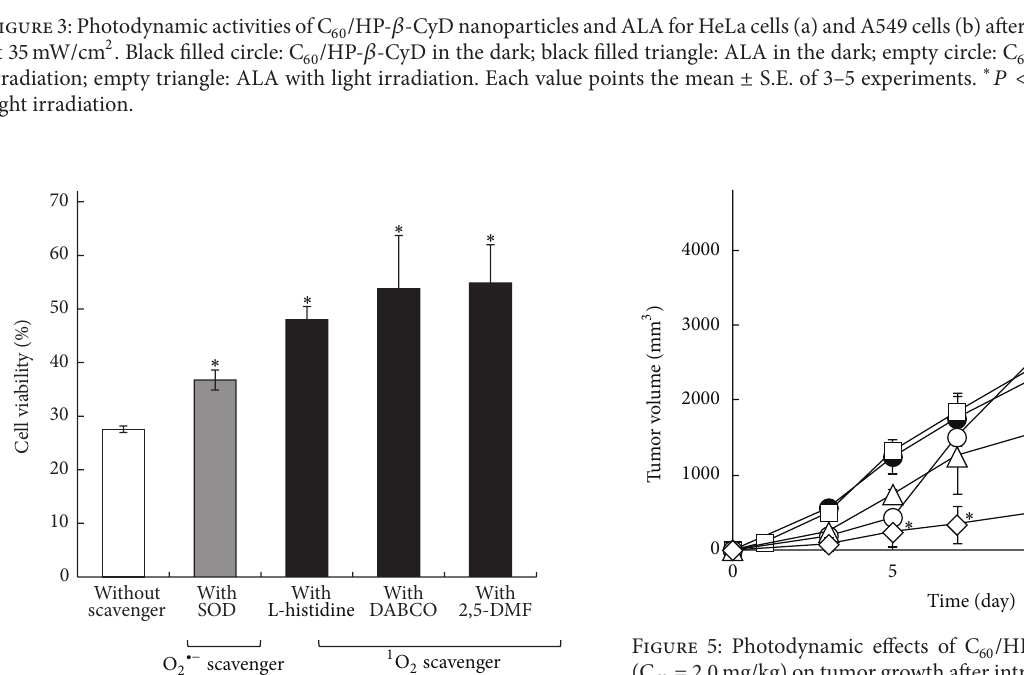
Figure 5: Photodynamic effects of C 60 /HP- 𝛽 -CyD nanoparticles (C 60 = 2.0 mg/kg) on tumor growth after intratumor injection to the tumor-bearing mice plus light irradiation. Black filled circle: saline; empty square: C 60 /HP- 𝛽 -CyD plus light irradiation (30J/cm 2 ); emptycircle:C 60 /HP- 𝛽 -CyDpluslightirradiation(60 J/cm 2 );empty lozenge: C 60 /HP- 𝛽 -CyD plus light irradiation (75J/cm 2 ); empty tri- angle: saline plus light irradiation (75 J/cm 2 ). Each point represents the mean ± S.E. of 3–9 experiments. ∗ 𝑃 < 0.05 versus